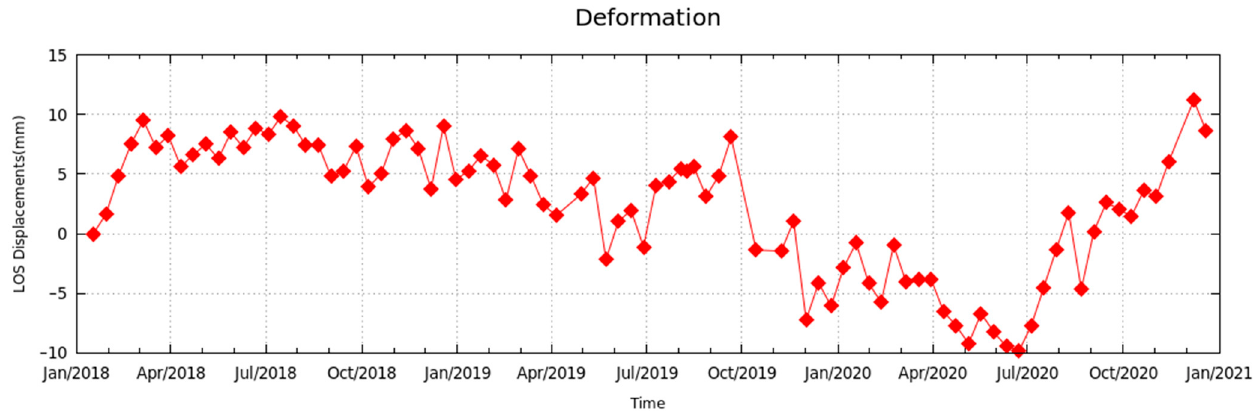
Figure 15. Deformation of point P5 during the monitoring period.